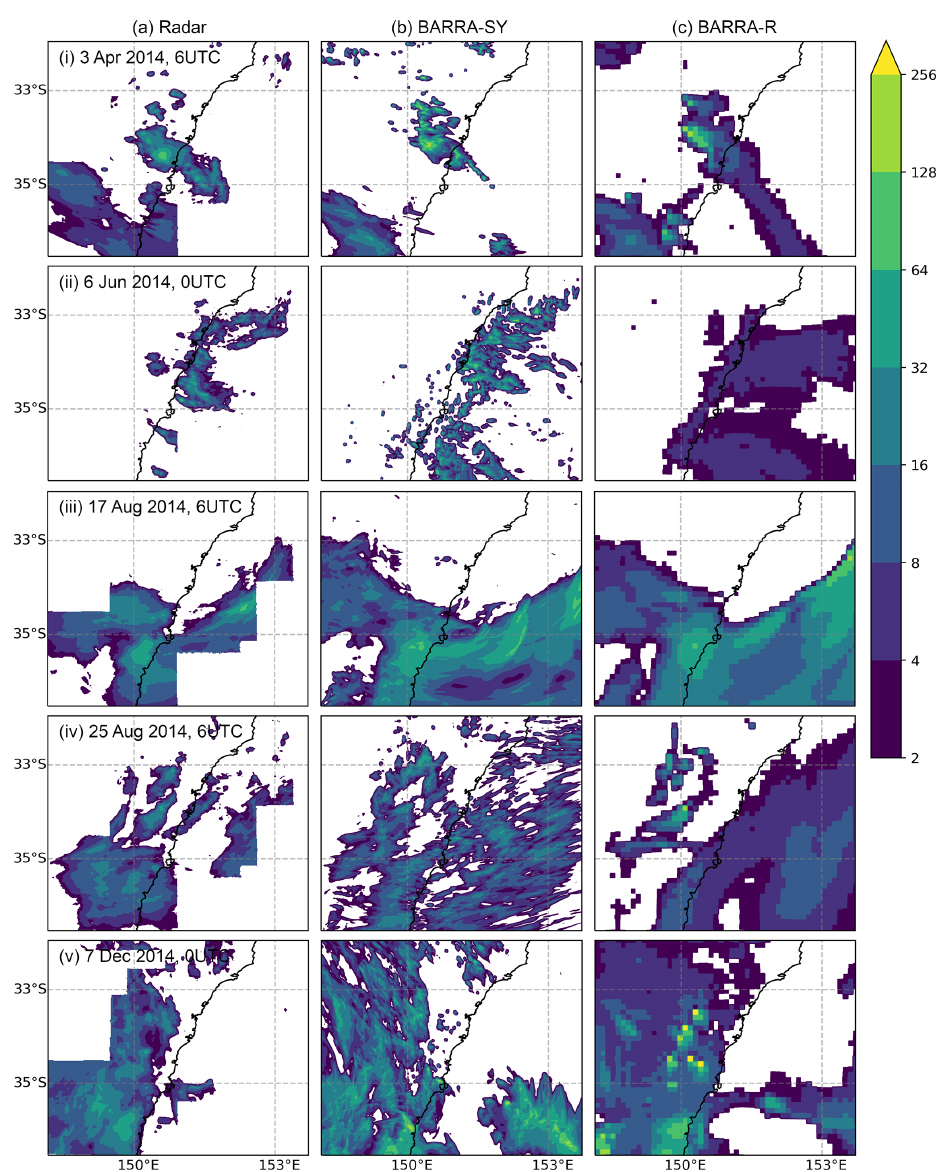
Figure 9. Simulated 6h rainfall accumulation [mm] in BARRA-SY and BARRA-R compared with rainfall derived from the composite radar network around the Sydney area for five